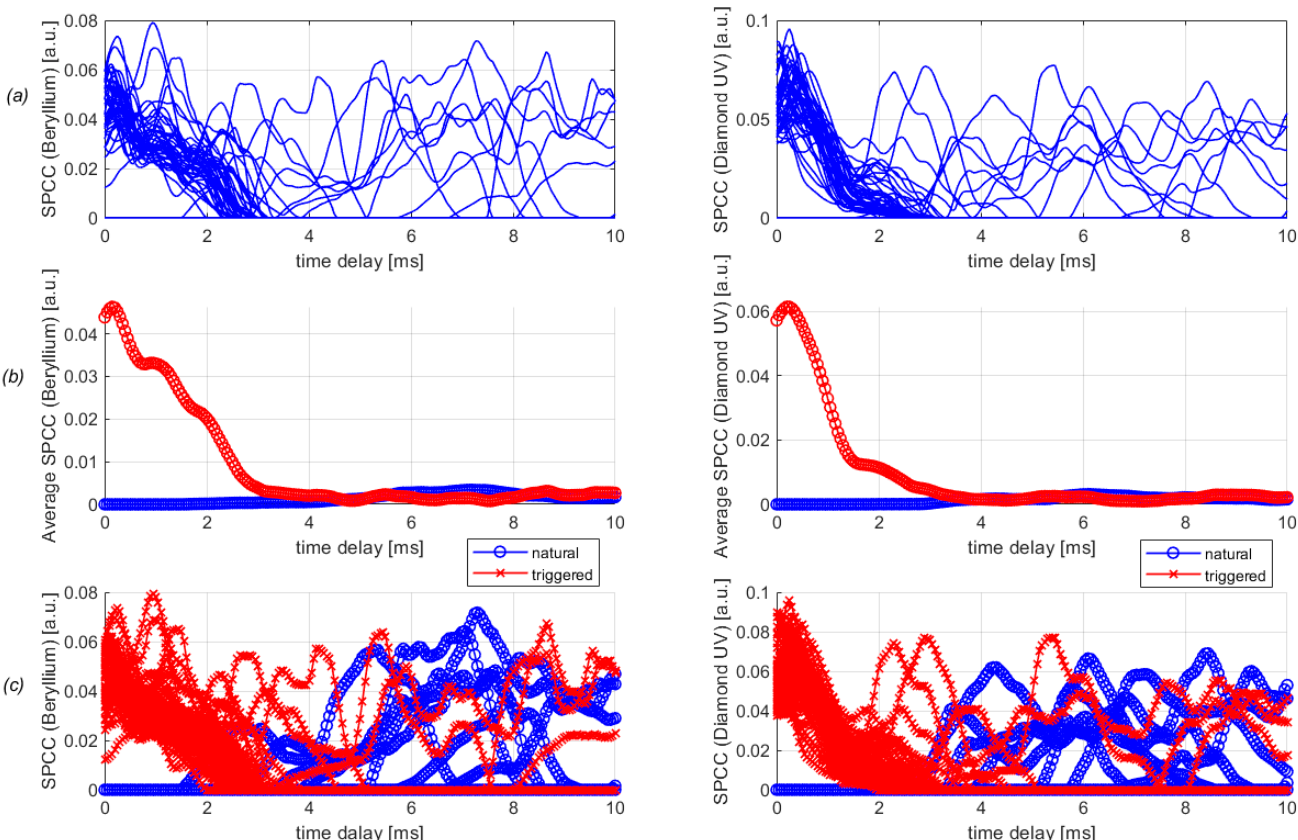
Figure 7. Top row ( a ): SPCC profiles (left using beryllium line, right using diamond UV) of the 114 detected ELMs. Middle row ( b ): average SPCC profile; bottom row ( c ): clustered SPCC profiles using the k-means algorithm.